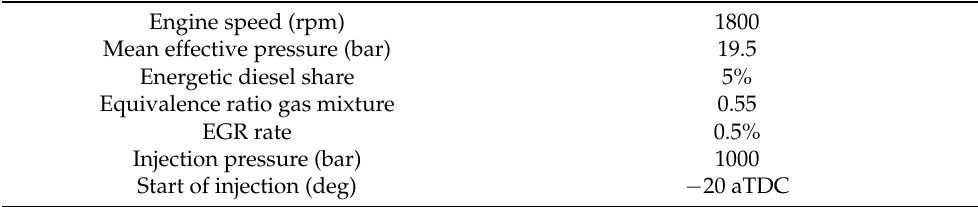
Table 2. Engine operating